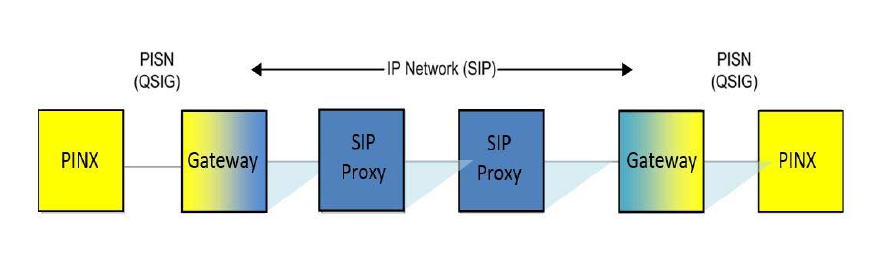
Figure 2 – Arrangement of entities when making calls from Q-SIG, via the SIP, to Q-SIG (Ecma International, 2008) Рис . 2 – Расположение сущностей при осуществлении звонков от Q-SIG, через SIP, к Q-SIG (Ecma International, 2008) Слика 2 – Распоред ентитета при реализацији позива од Q-SIG, преко SIP, на Q- SIG (Ecma International,